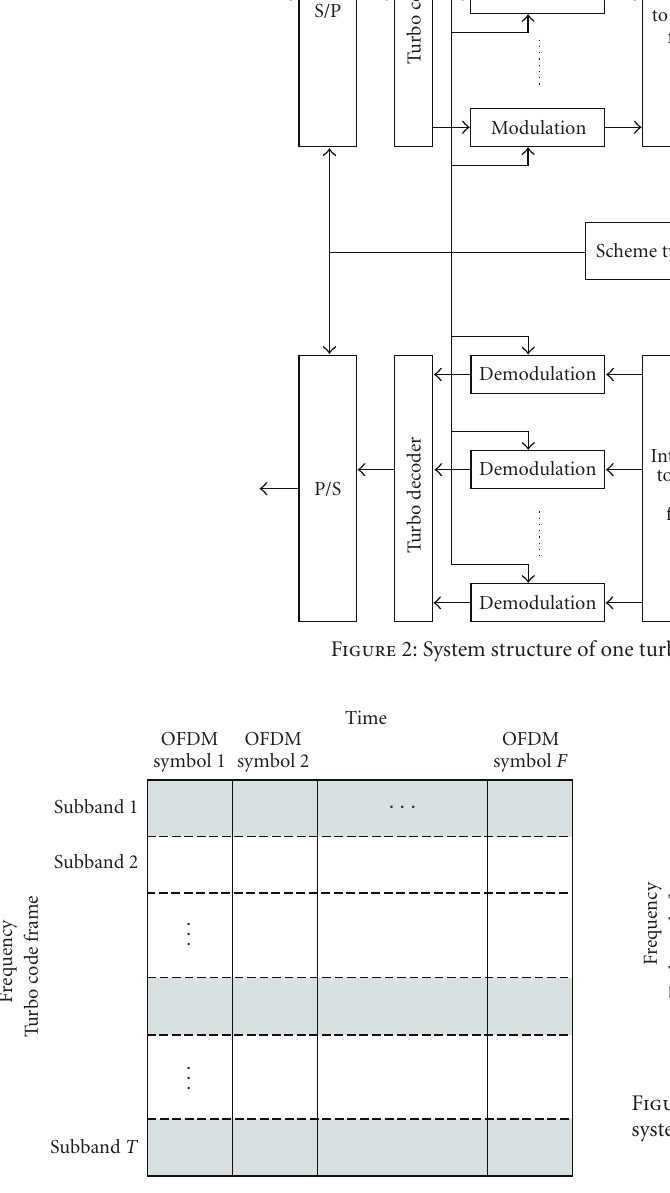
Figure 3: Transmission block structure of separate turbo code adaptive system.